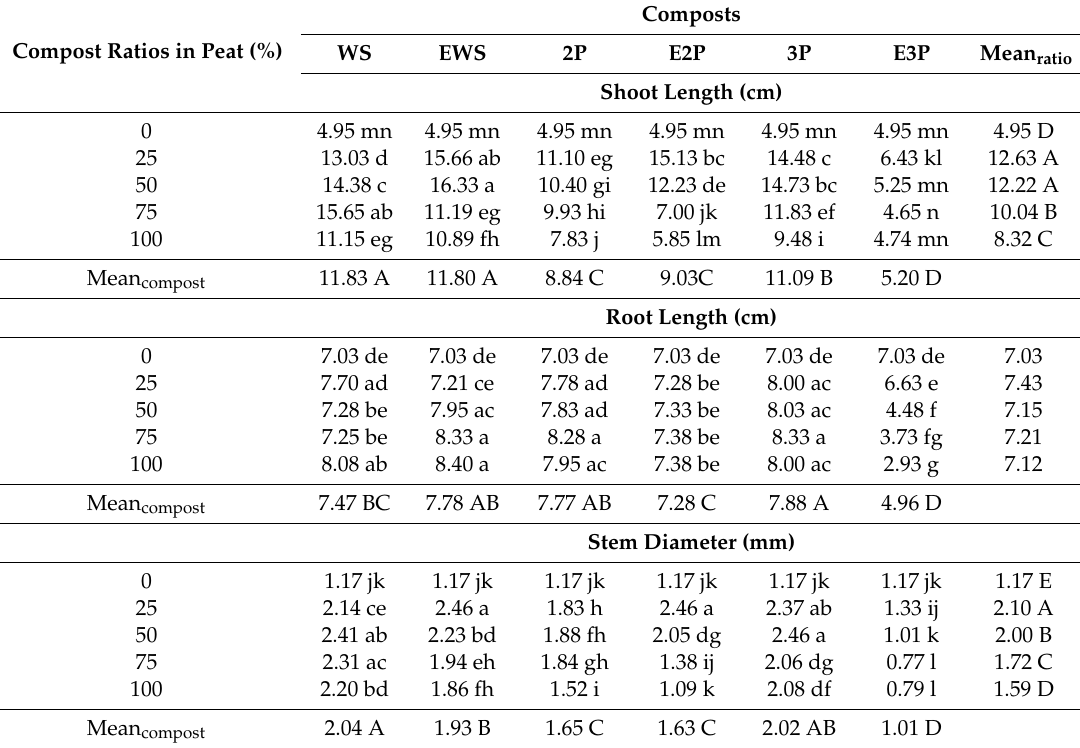
Table 6. E ff ects of treatments on